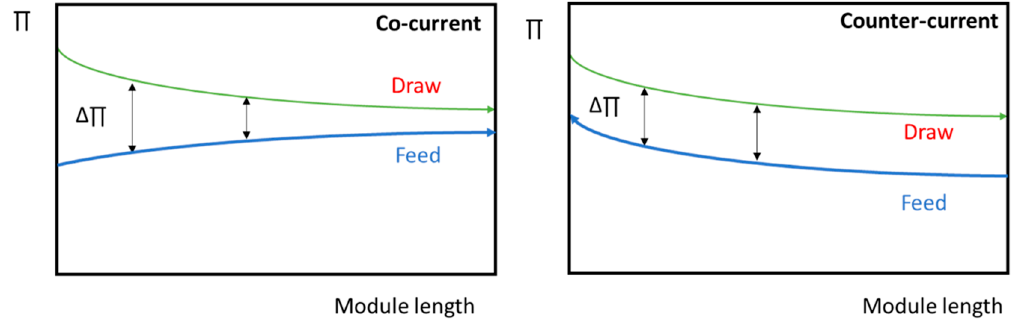
Figure 5. Description of osmotic pressure of feed and draw stream in along a FO module, depending on operation in co- and counter-current (adapted from on operation in co- and counter-current (adapted from [255]).